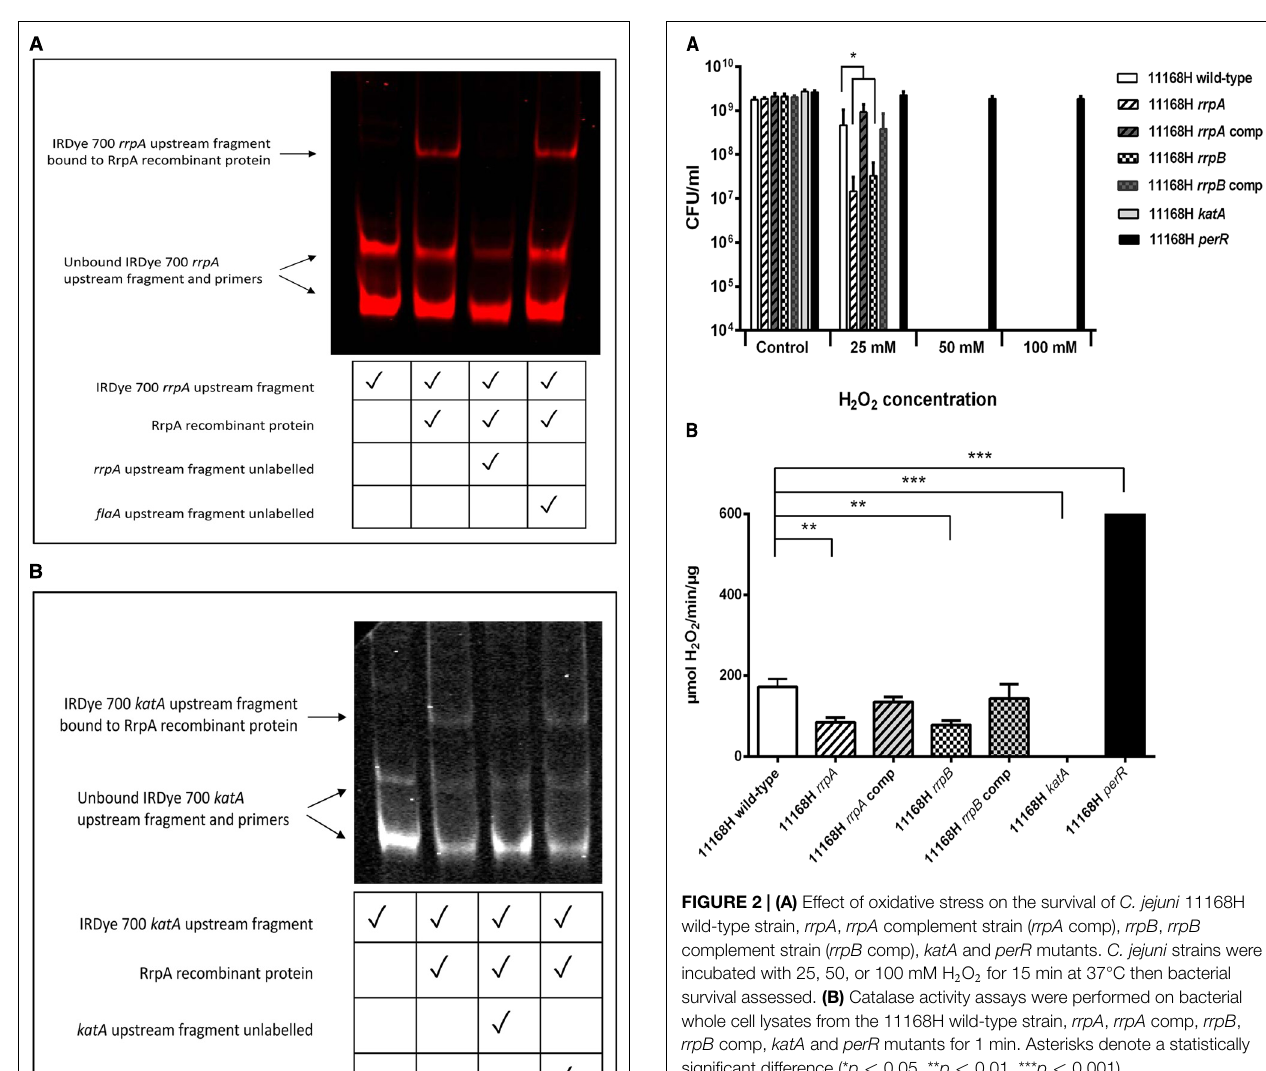
( Figure 5A ) or menadione ( Figure 5B ) stress compared to the wild-type strain. A ahpC mutant was used as a control for cumene hydroperoxide stress as AhpC is known to break down this compound (Baillon et al., 1999). A sodB mutant was used as a control for menadione stress because SodB is the main enzyme that reduces superoxides (Palyada et al., 2009). The 11168H sodB mutant was highly sensitive to menadione